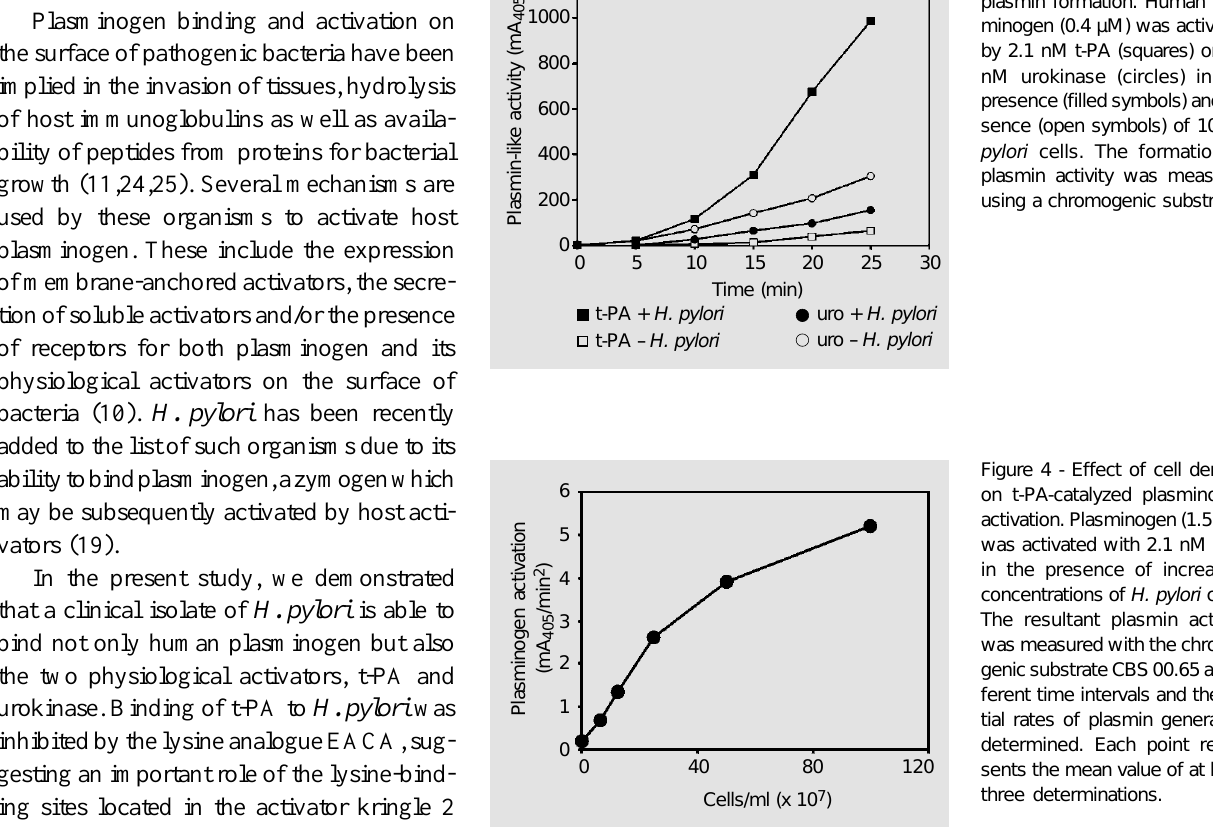
Figure 3 - Effect of H. pylori cells on t-PA- and urokinase-catalyzed plasmin formation. Human plas- minogen (0.4 µM) was activated by 2.1 nM t-PA (squares) or 0.2